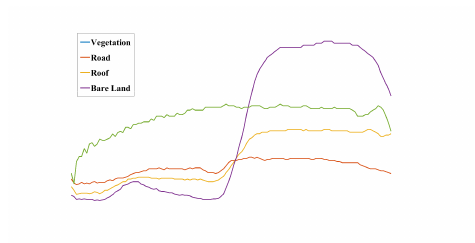
Figure 4. The spectral curves of the features are obtained from a single image, there is a difference in distinct features tral information between different images: for the reasons the spectral information were extracted from distinct images which are captured at different time and angles, and the influence of the noise. The mismatching were produced probably. And thus it is necessary to optimize the spectral information. A typical strategy is to calculate the median of all corresponding spectral informa- tion as the final spectral information. The new 3D point cloud is displayed by using its hyperspectral information. Heres a display of 61th, 25th, 11th band combinations applied to the point clouds, displayed as a red, green, blue (RGB). As shown in Figure 5.